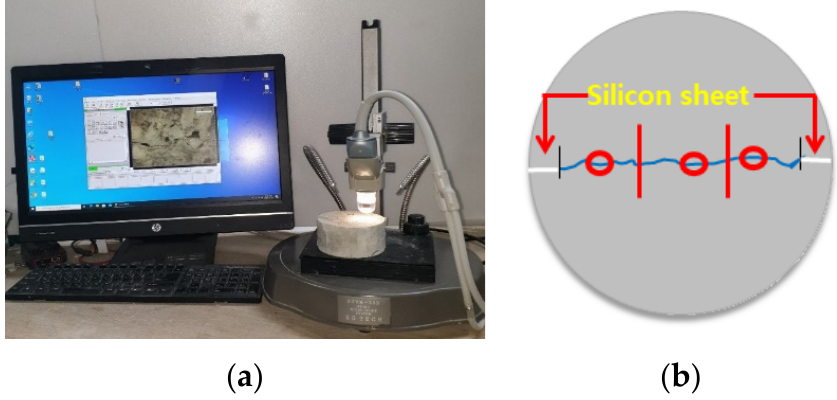
Figure 11. Crack closing test: ( a ) crack measuring equipment; ( b ) crack observation location.